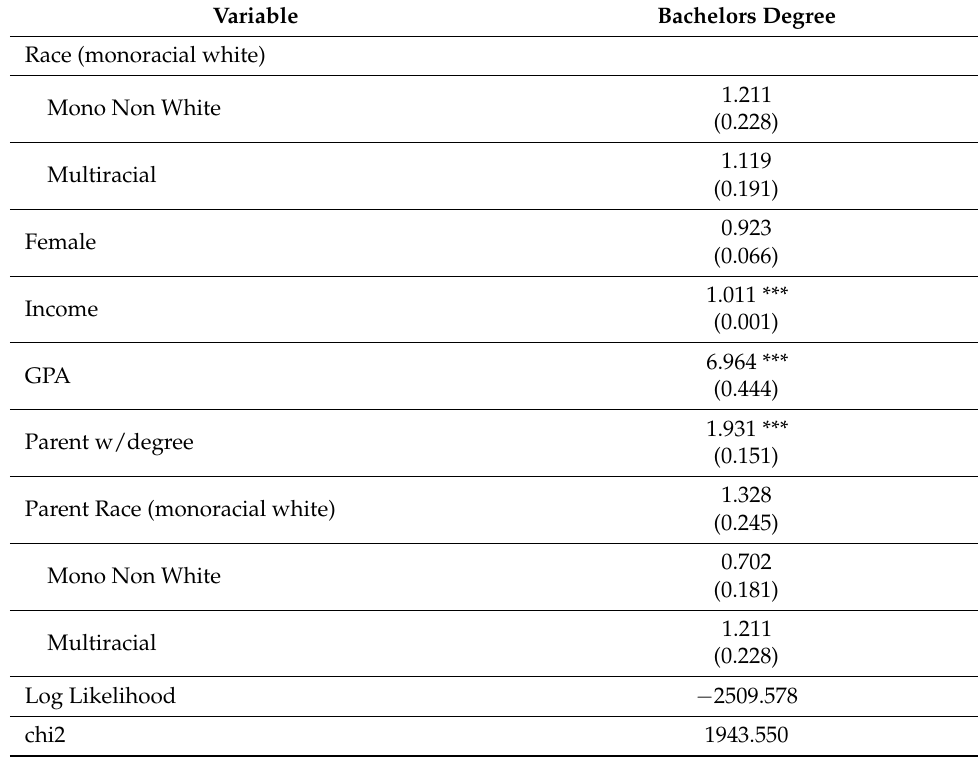
Table A5. Logistic Regression Predicting Degree